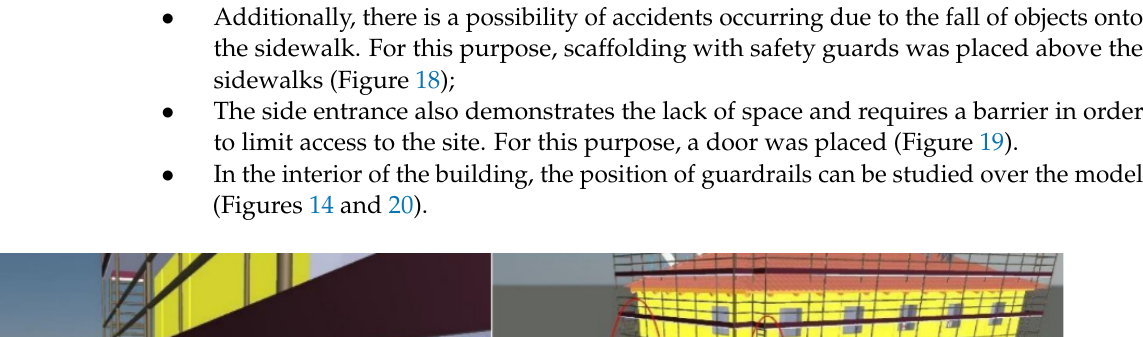
Figure 17. Hazard mitigation in the front entrance of the construction site.